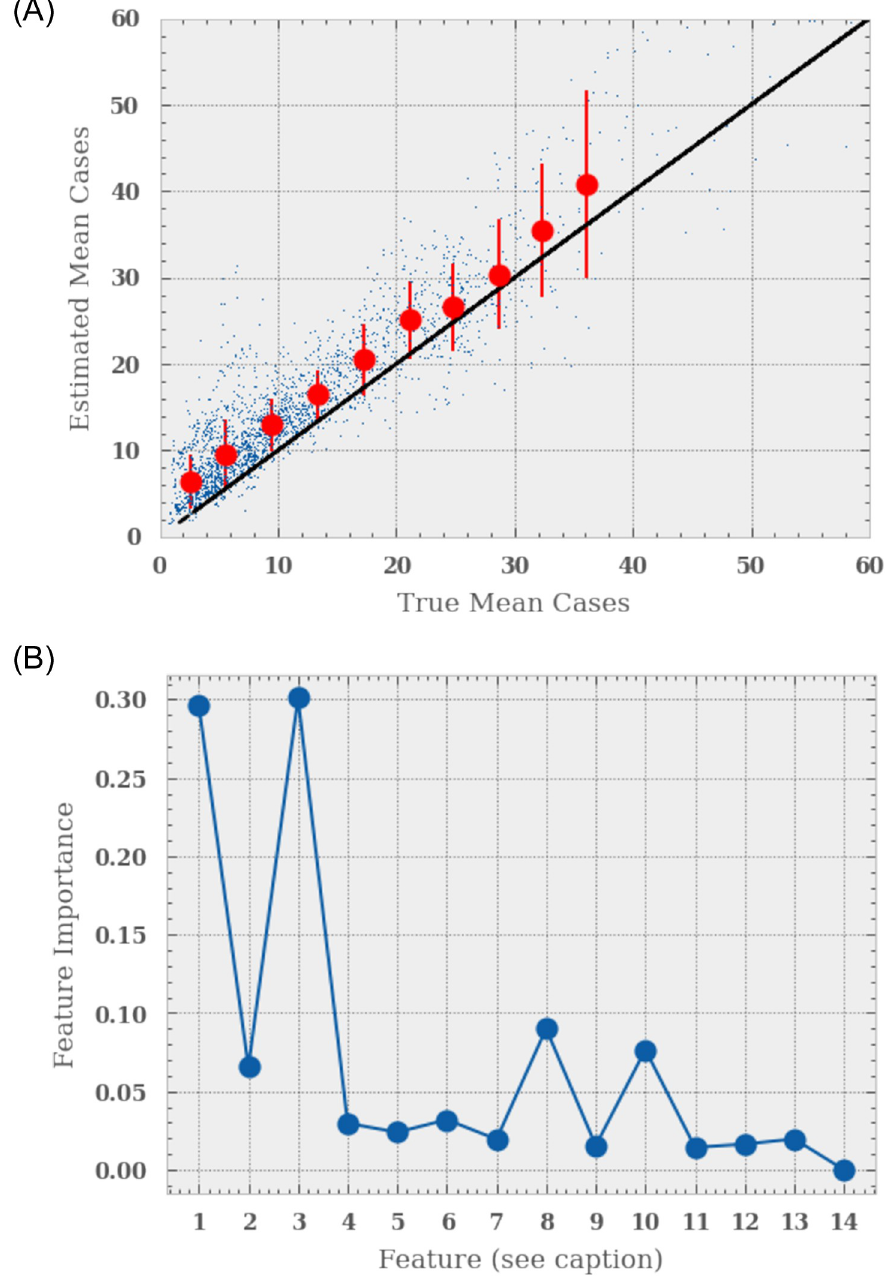
Fig 3. The performance of the Random Forest Regressor at estimating the mean malarial case rate over a 26 week period using data from the first 13 weeks. We set up a feature base and train the regressor. The top panel shows the estimated mean case rate as a function of the true case rate for the test set. The red markers show the mean and variance in binned true case rates. We find that the estimated case rate has a slight bias. The bottom panels shows feature importance from the Random Forest. The legend is as follows, the first seven as the mean 13 value for (1): absolute number of malaria cases, (2):the absolute number of consultations, (3): the absolute number of tests needed, (4): the Gaussian smooth case rate of malaria over a 30km region, (5): the Gaussian smooth case rate of malaria over a 100km region, (6):the rain-fall in mm over a 15km Gaussian smoothed area and 15day time period, (7): the amount of surface-water, and the variance in each feature over the same 13 week